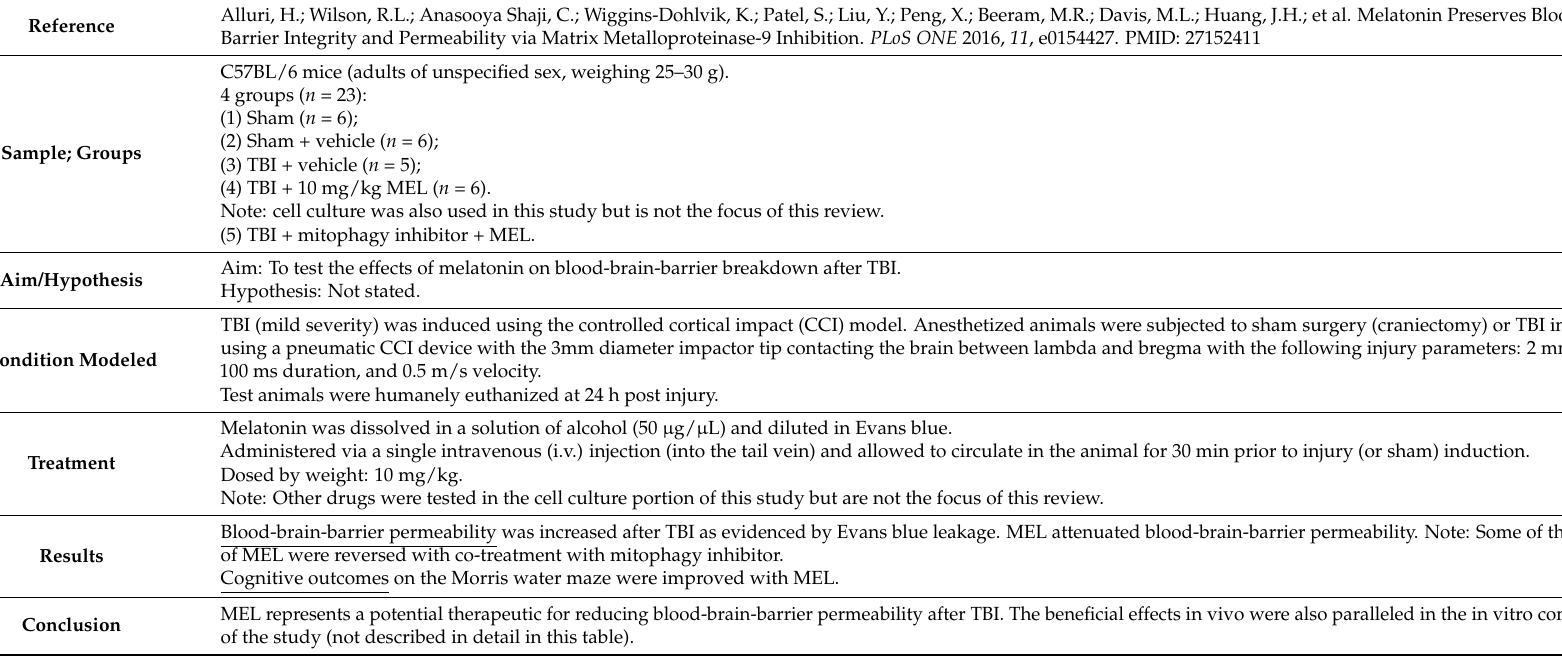
Table A21. Alluri et al. (2016) Study